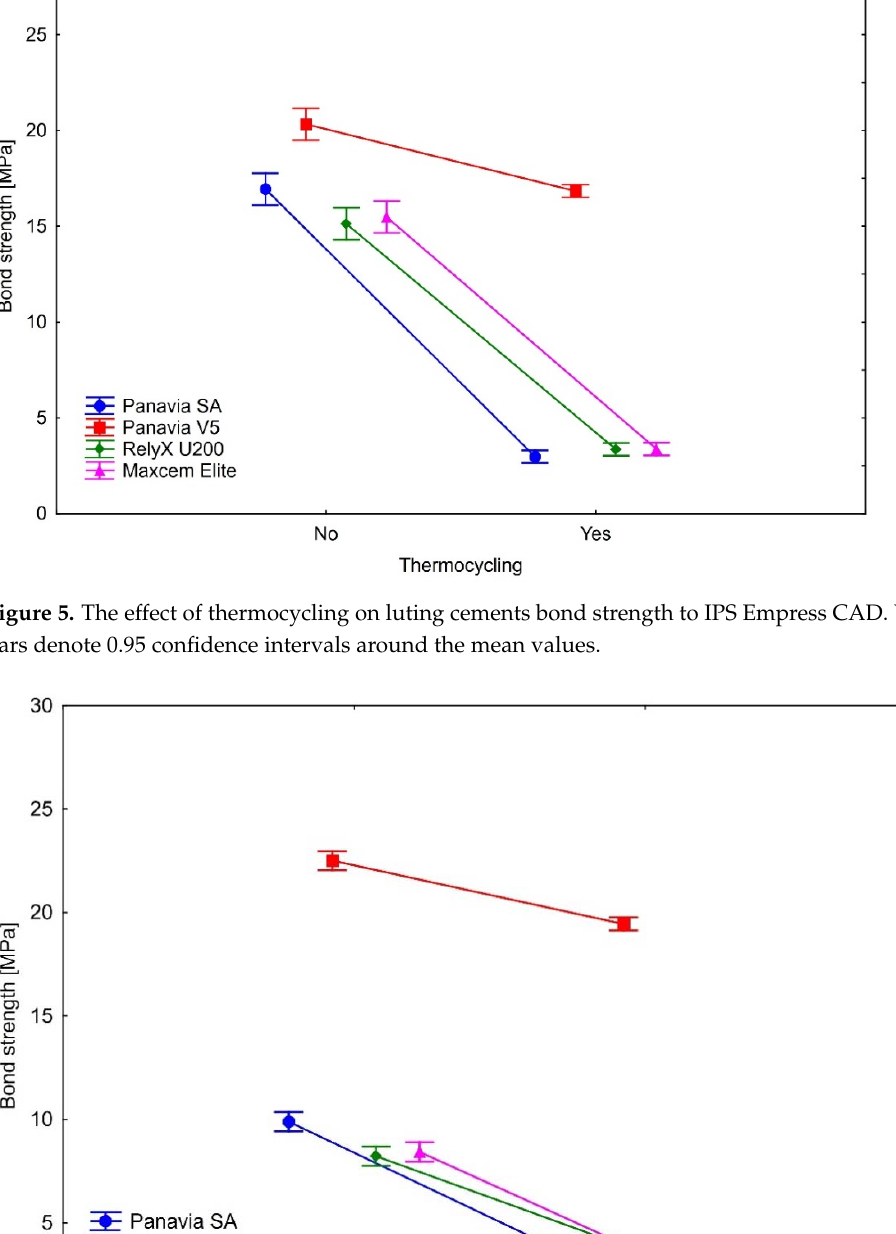
Figure 4. The effect of thermocycling on luting cement bond strength to IPS e.max ZirCAD. Vertical bars denote 0.95 confidence intervals around the mean values.